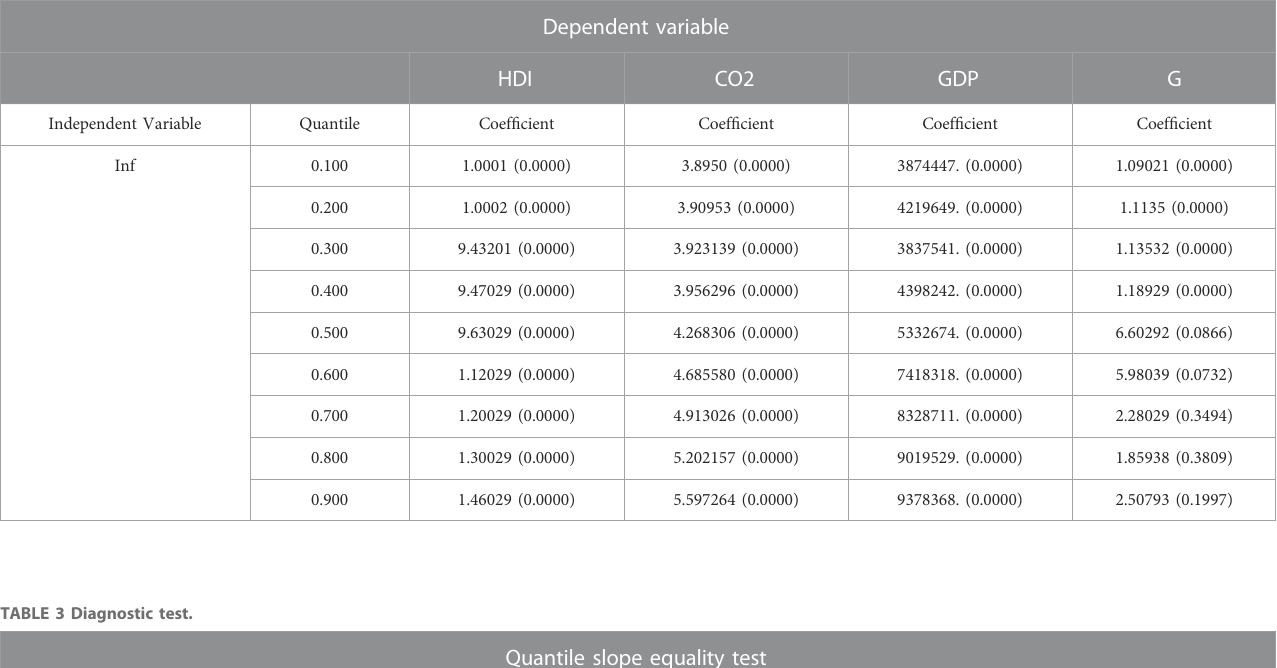
TABLE 2 Quantile regression results.